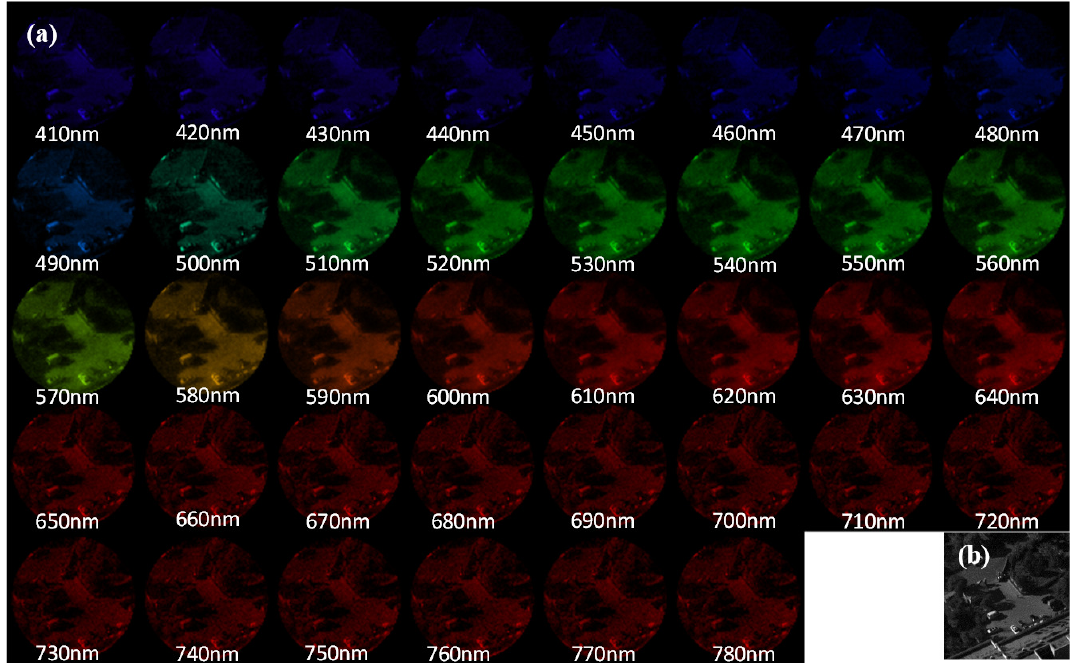
Figure 4. Experimental results of a natural scenes at 1km away. ( a ) Reconstructed spectral images by the GISC spectral camera; ( b ) the original image recorded by the monochrome monitoring